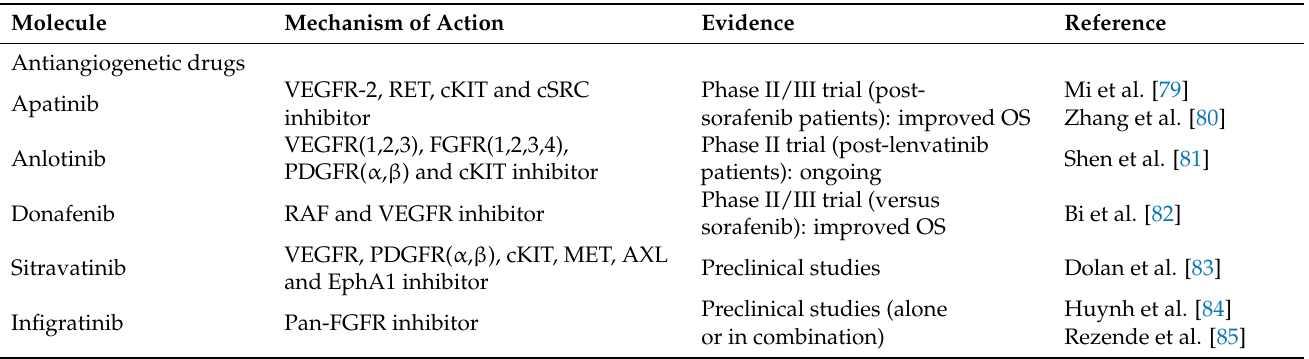
Table 1. New molecules overcoming resistance to approved anti-angiogenetic drugs in both preclini- cal and clinical